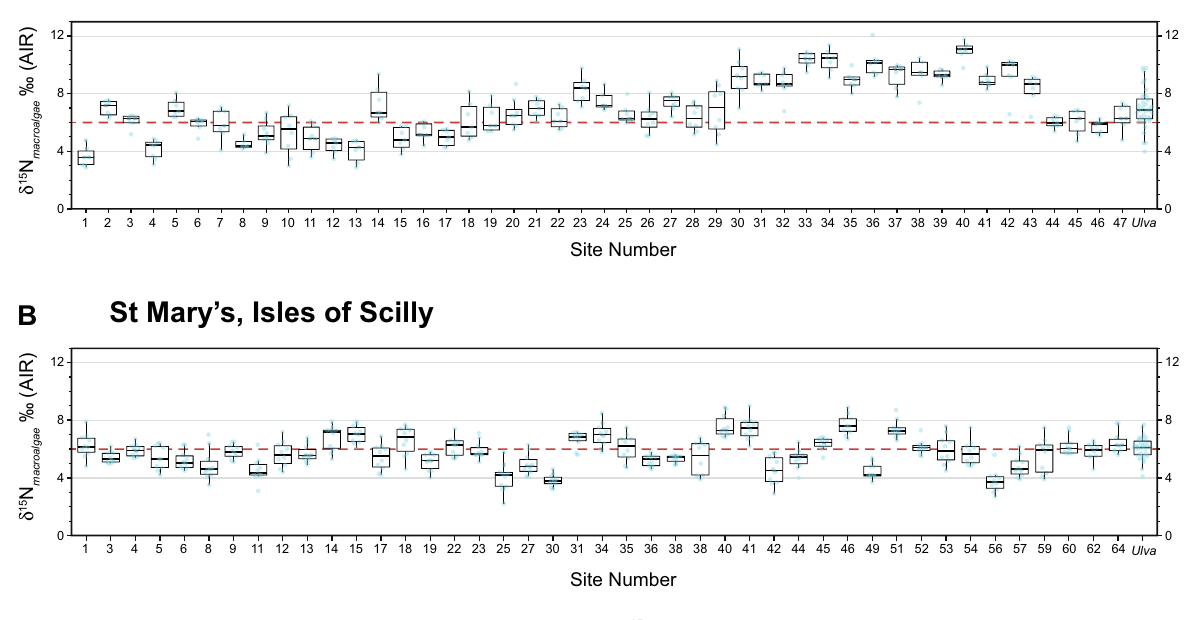
Figure 2. Box and whiskers plots of macroalgae δ 15 N from Jersey ( A ) and St Mary’s ( B ). All numbered sites represent Fucus results. All Ulva results for the islands have been grouped as one dataset and are presented on the farthest right of each graph. δ 15 N values above the dashed red line represent coastal environments that are affected by sewage/effluent. Macroalgae δ 15 N elevation is recorded for St Aubin’s Bay (Sites 30–43) linked to the Bellozanne STW